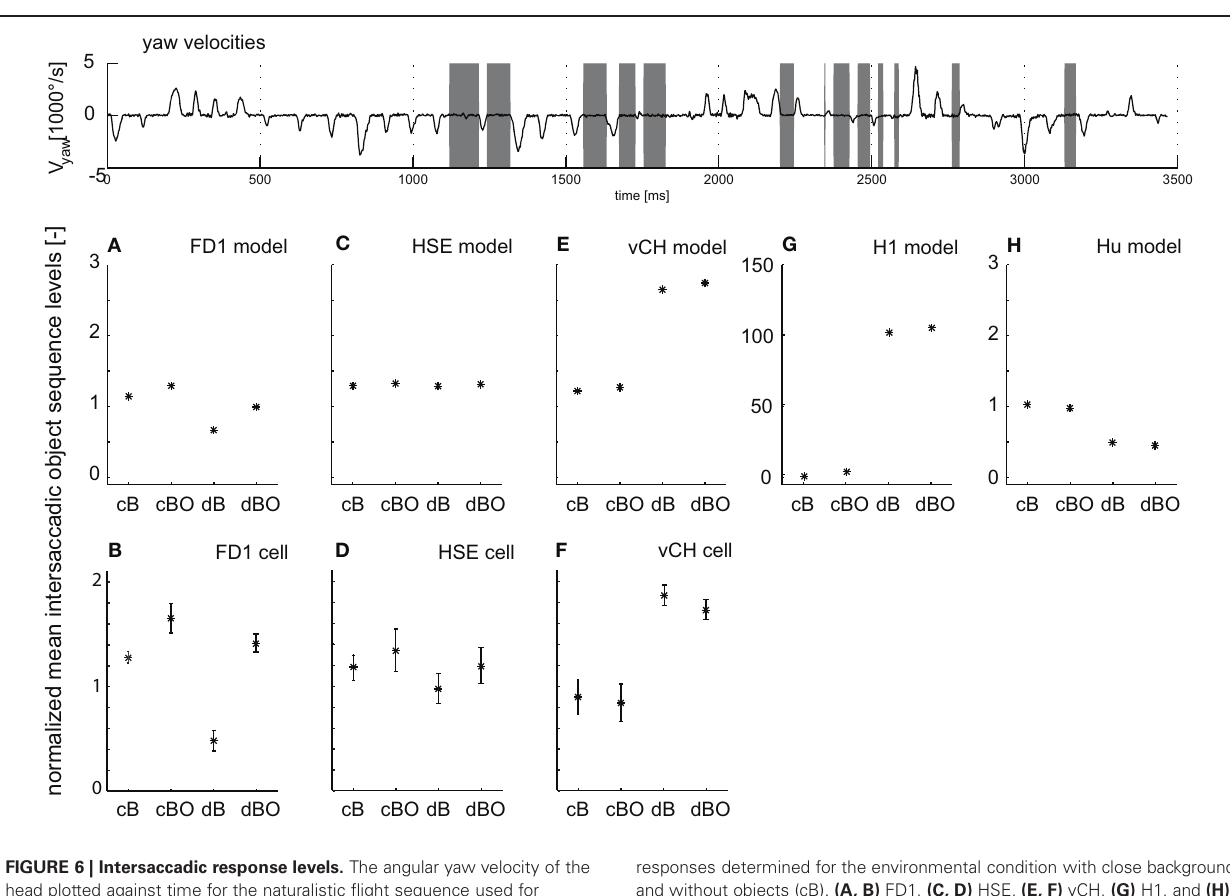
responses determined for the environmental condition with close background and without objects (cB). (A, B) FD1, (C, D) HSE, (E, F) vCH, (G) H1, and (H) Hu. Error bars shown for experimental data represent standard deviations across cells; experimental details are in Liang et al. (2012). Note: The experimental HS responses were not only taken from HSE, but—since the responses were not systematically different under the stimulus conditions tested—also from HSS and HSN; details are given in Liang et al.